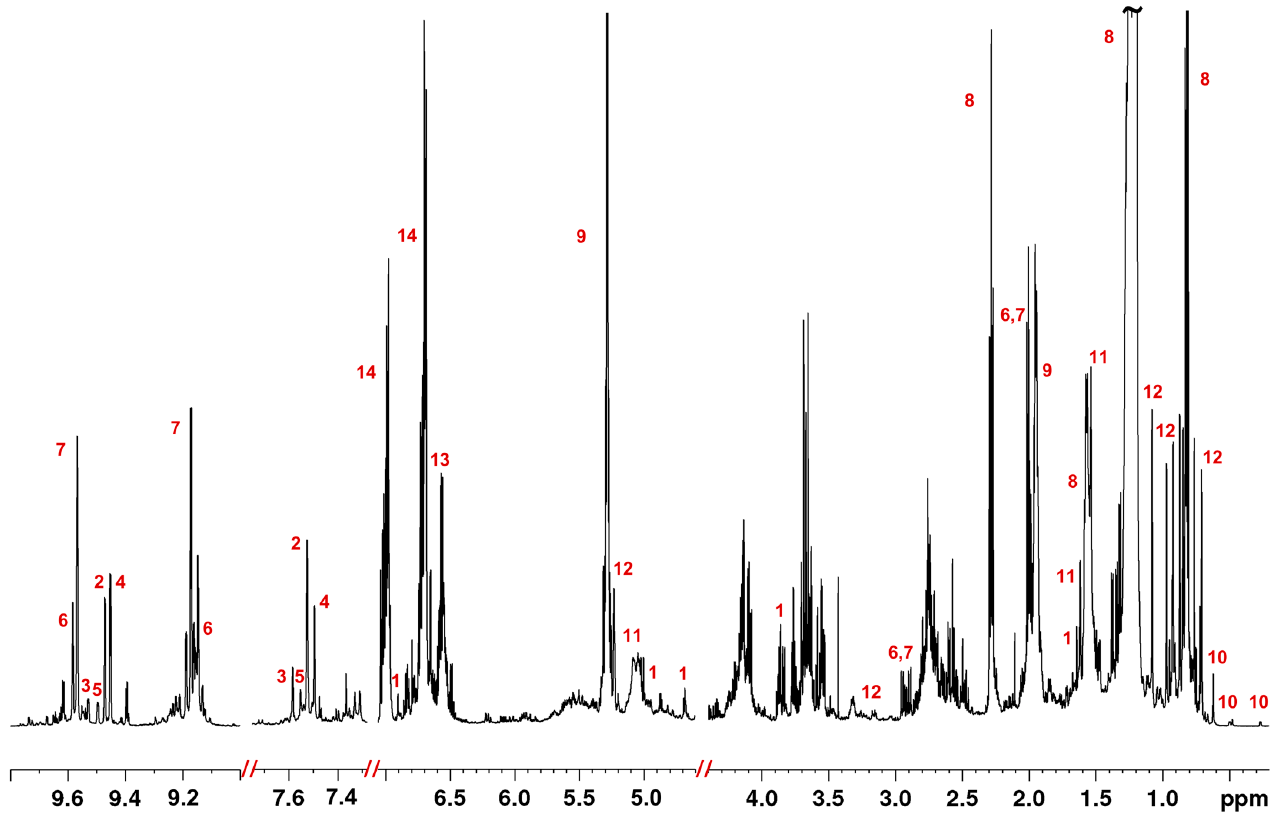
Figure 4. Annotated representative 1D 1H NMR spectrum of a Greek EVOO (600 MHz, chloroform- d , reference with IS at 0 ppm). 1: Acetoxypinoresinol; 2: monoaldehydic form of oleuropein aglycon